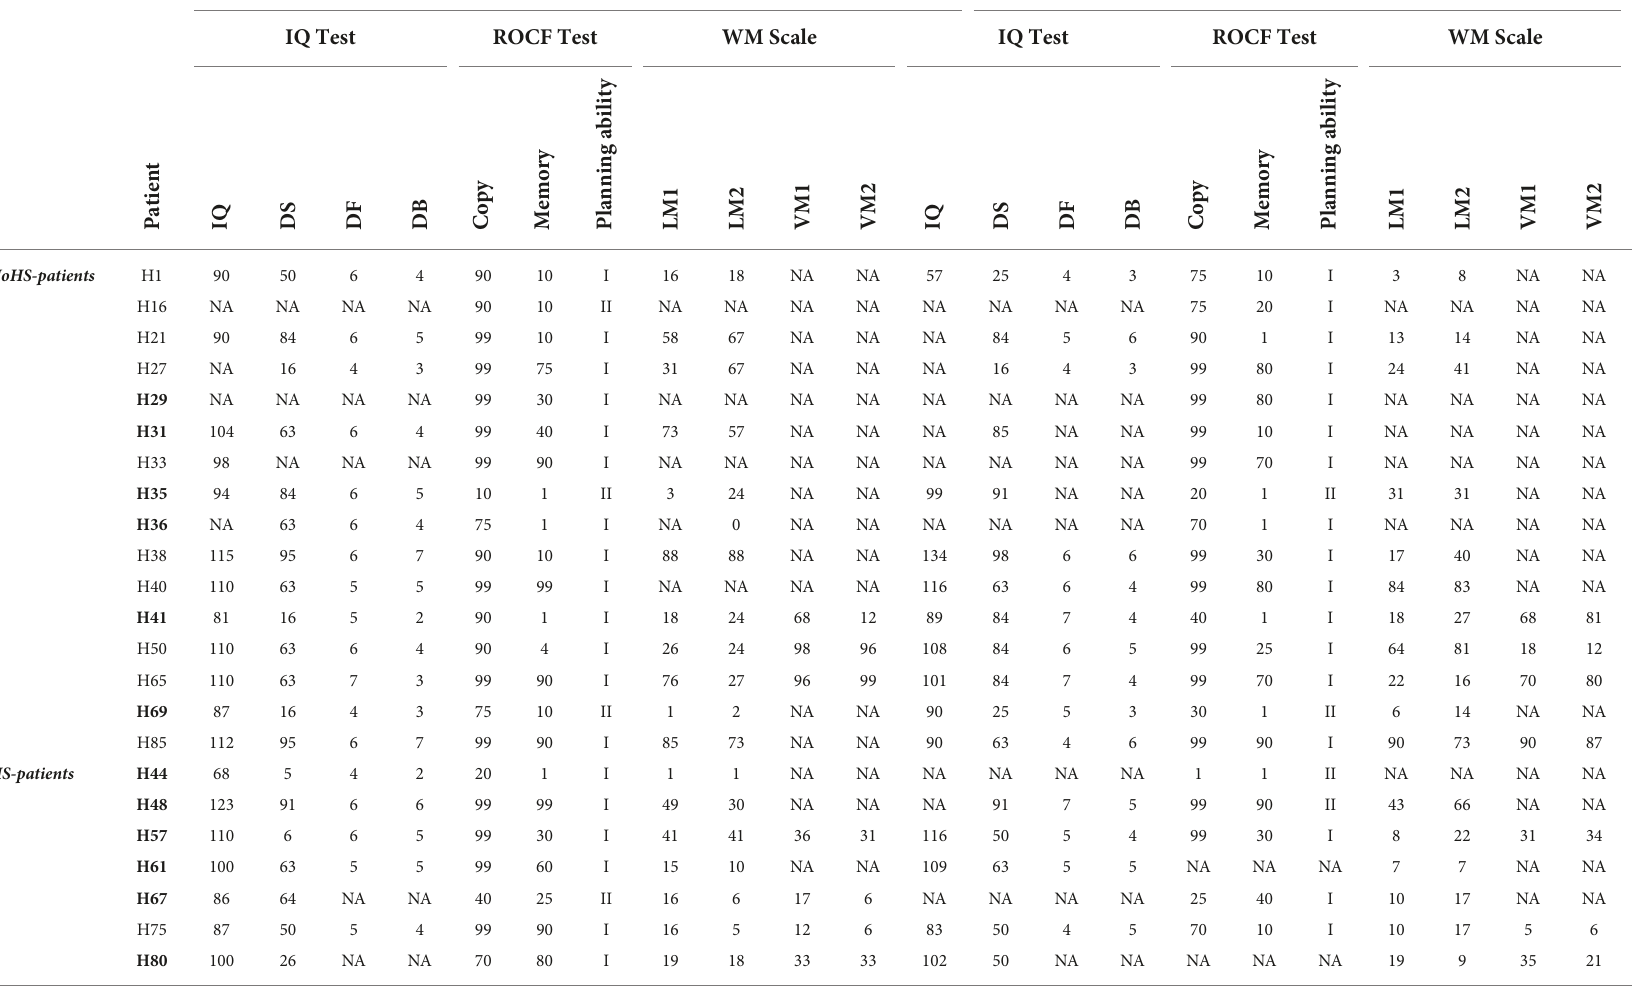
TABLE 6 Summary of neuropsychological data of NoHS-patients and HS-patients, before and after surgery. Before surgery After surgery IQ Test ROCF